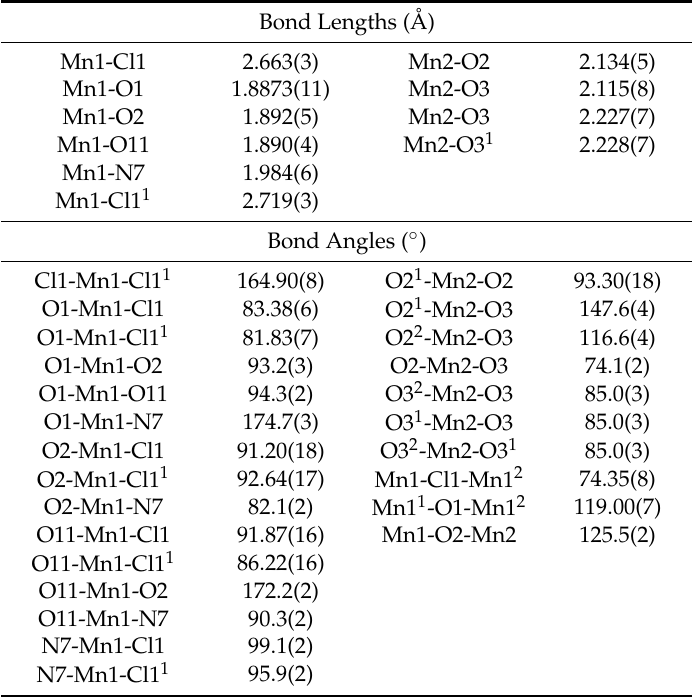
Table 1. Relevant bond distances (Å) and angles ( ◦ ) for compound 1